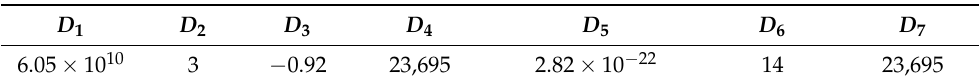
Table 1. Material parameters for combined time hardening equation, where temperature is expressed in K, time in s, and stress in MPa.